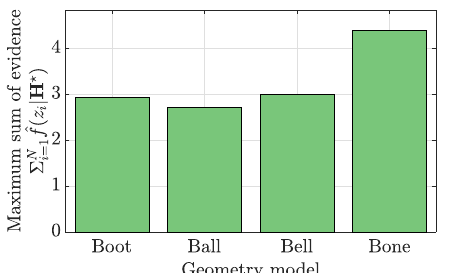
Figure 17. The maximum sum of evidence for the estimated pose of each geometry model. note that the correct geometry, the Bone , is most evidenced by the point cloud data.